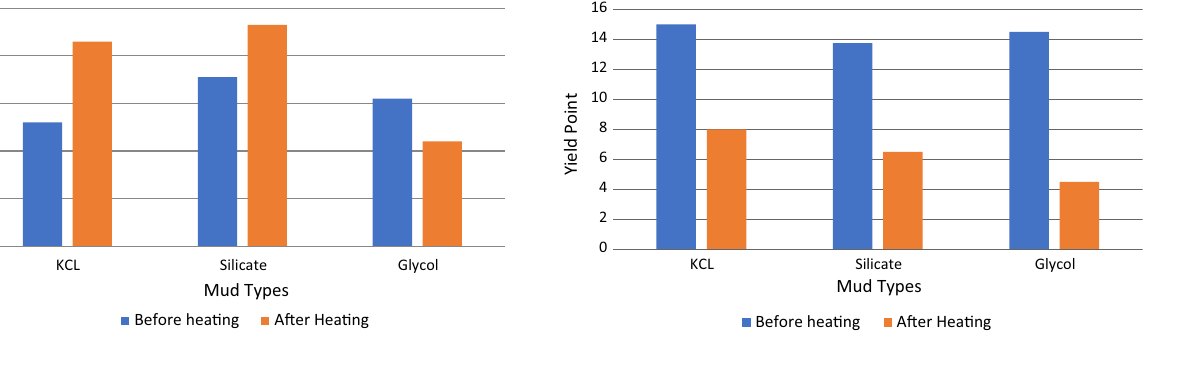
Fig. 3 Yield Point for different drilling fluids